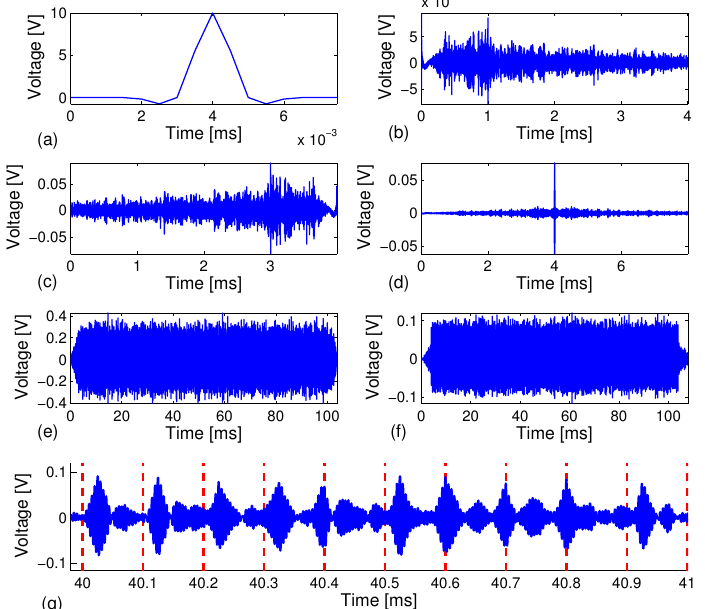
Figure 9. Snapshots of waveforms obtained experimentally from TR-PPM data communications on a stainless steel pipe filled with water at a data rate of 10 kbps. ( a ) Gaussian pilot signal of 8 µs ; ( b ) received response after channel sounding; ( c )